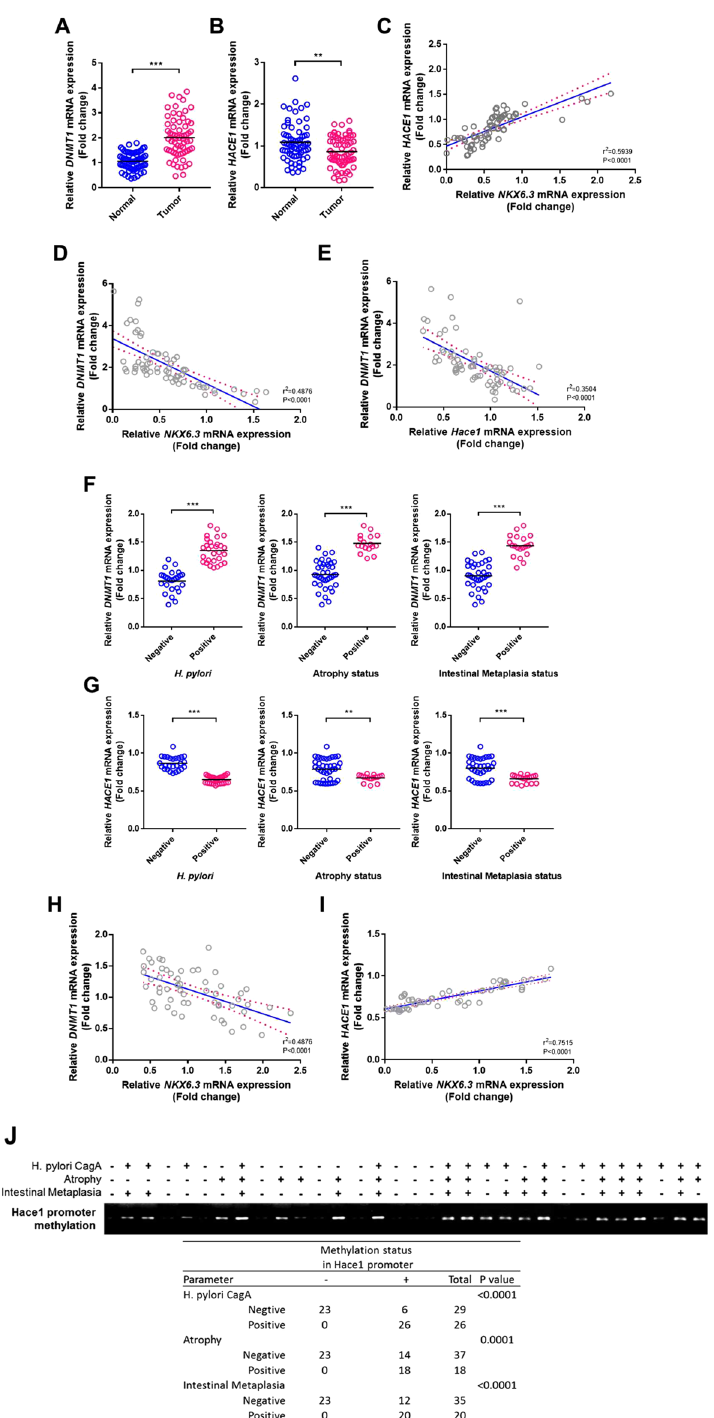
Figure 7. NKX6.3 is correlated with DNMT1 and Hace1 in gastric mucosae and gastric cancer tissues. ( A and B ) The relative mRNA expression levels of DNMT1 ( A ) and Hace1 ( B ) in noncancerous (Normal) and gastric cancer (Tumor) tissues are illustrated by scatterplot. The median expression level of each group is indicated by horizontal line. ( C–E ) A positive correlation of NKX6 . 3 with Hace1 and inverse correlation of DNMT1 expression with NKX6 . 3 and Hace1 expression. ( F and G ) Expression levels of DNMT1 (F) and Hace1 ( G ) in 55 gastric mucosae with H . pylori infection, atrophy and intestinal metaplasia. ( H and I ) A positive correlation between NKX6 . 3 and Hace1 expression and inverse correlation between DNMT1 and NKX6 . 3 expression in non-neoplastic gastric mucosae. ( J ) Methylation status of Hace1 promoter region examined by MSP. Hypermethylation of Hace1 gene was observed only in the gastric mucosae with H . pylori infection, atrophy, and/or intestinal metaplasia. *** P < 0.001, ** P < 0.005, based on the two-way ANOVA, linear progression and Chi-square